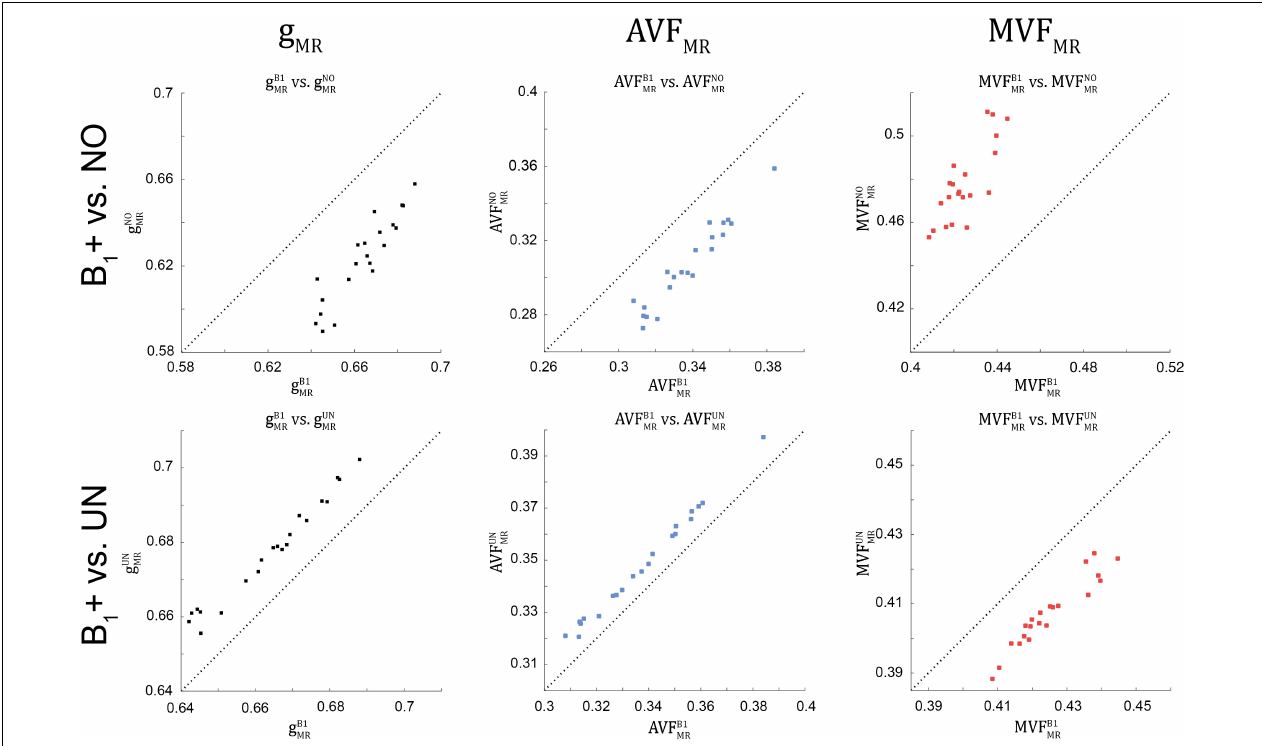
FIGURE 8 | Scatter plots of g MR , AVF MR , and MVF MR , plotting values obtained without B 1 + correction (superscript: NO, top row) and with UNICORT B 1 + correction (superscript: UN, bottom row) against values obtained with the reference method, i.e., B 1 + field map correction (superscript: B1). A dashed unit slope line is plotted for reference. Each point in the scatter plot represents the group-averaged value in a single ROI (see Figure 4 for the locations of the 21 high-SNR ROIs).